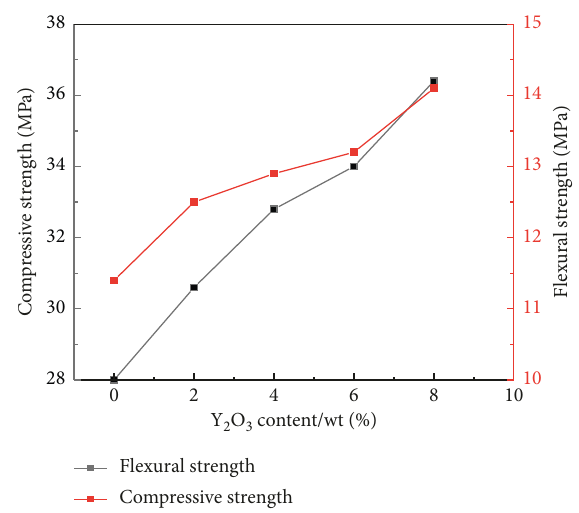
Figure 4: Effect of Y 2 O 3 amount on flexural strength and com- pressive strength of mullite porous